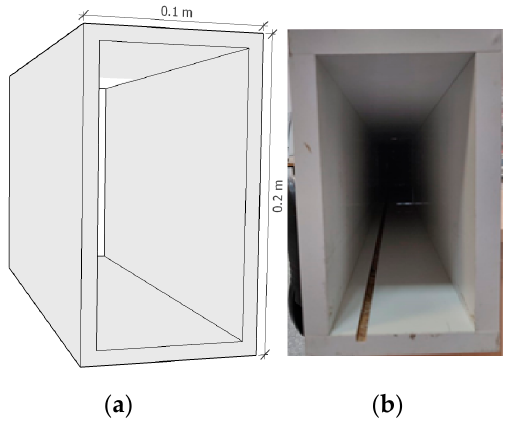
Figure 6. Scale tunnel model built out of Formica of rectangular profile with a height of 0.2 m and width of 0.1 m ( a ) a schema, and ( b ) a real tunnel model.